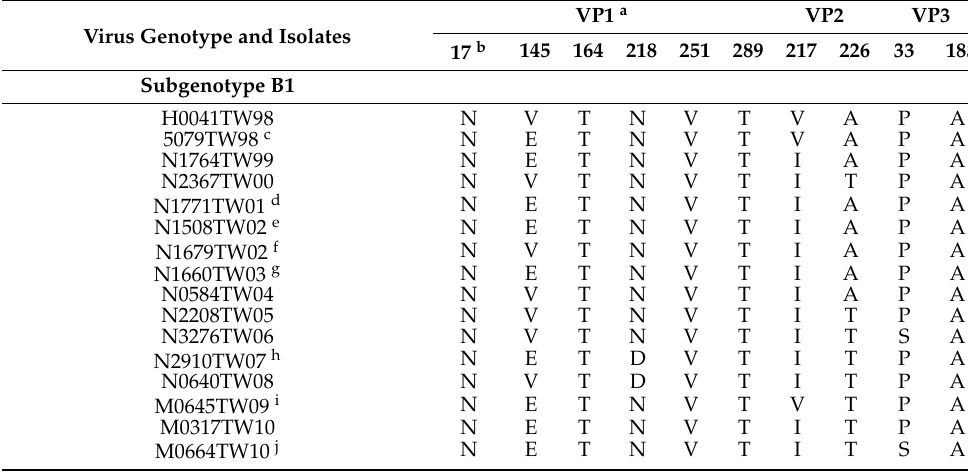
Table 1. Amino acid sequence comparison of capsid protein of CVA16 in Taiwan. Virus Genotype and